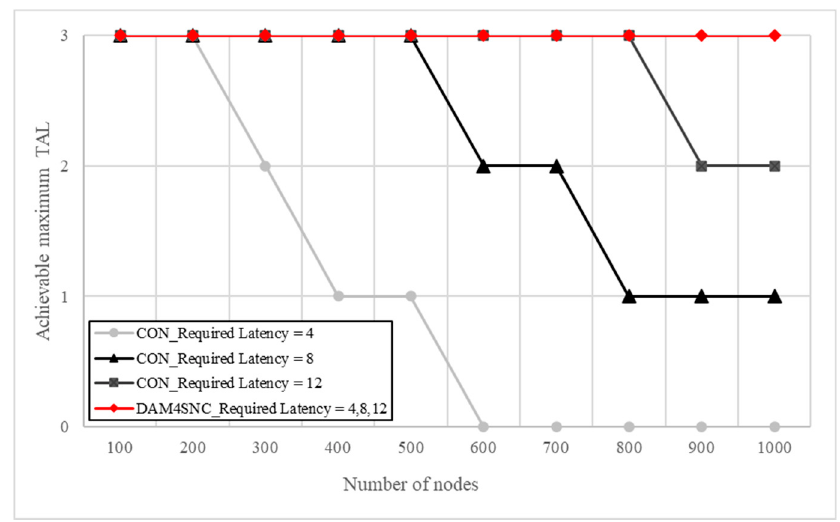
Figure 7. Achievable maximum TAL for the required latency conditions for each model.